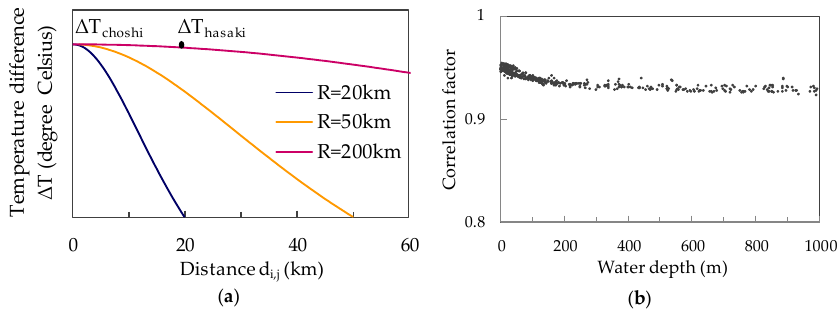
Figure 12. ( a ) Variation of sea surface temperature differences with the influence radii in the Cressman function. ( b ) Distribution of correlation coefficients between OSTIA and observations at Choshi.